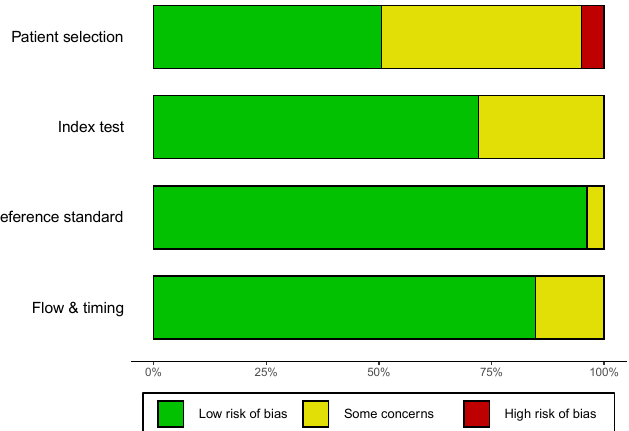
Figure 2. Quality assessment of the included studies by the revised QUADAS-2. QUADAS-2, Quality Assessment of Diagnostic Accuracy Studies-2.